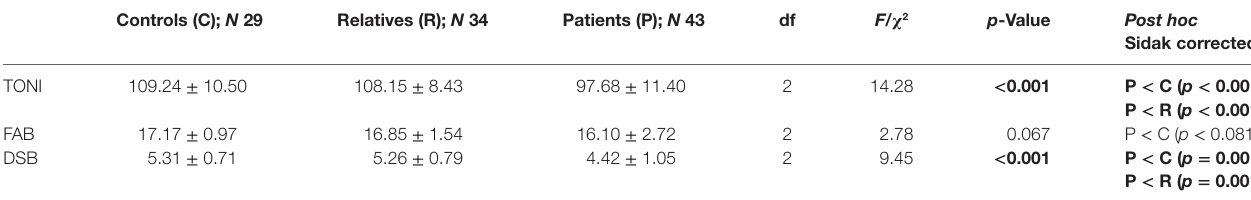
Table 2 | Nonverbal intelligence, frontal lobe and working memory function of the